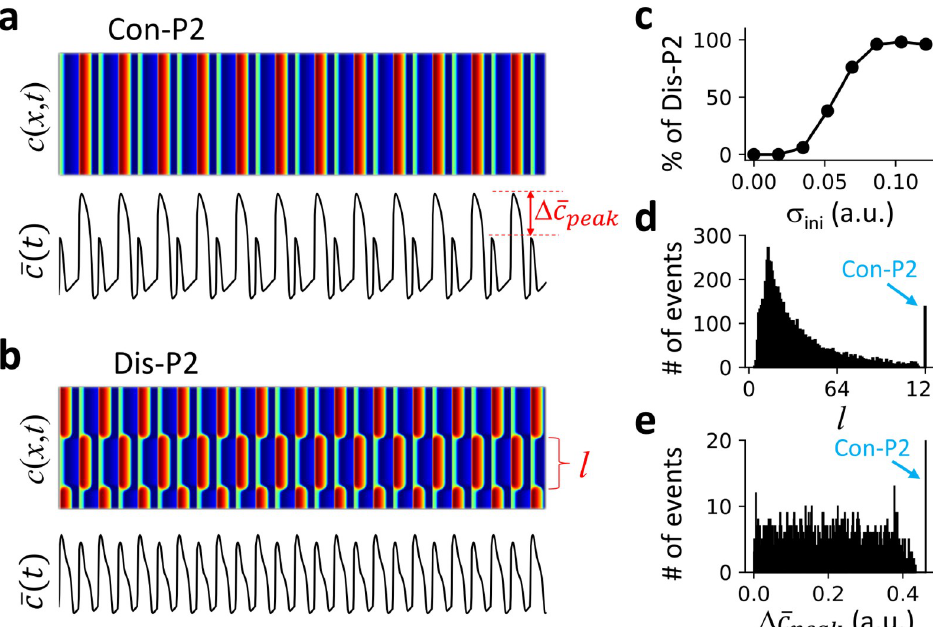
Fig 2. Excitation patterns and dynamics in a 1D array of coupled FHN units without DGF. The pacing period T = 45 and system size L = 128. a . An example of Con-P2 patterns and the corresponding global signal � c ð t Þ . b . An example of Dis-P2 patterns with a different initial condition from panel a, and the corresponding � c ð t Þ . c . Percentage of Dis-P2 patterns versus the standard deviation ( σ ini of the random initial conditions. s trials for each σ value in the plot. d . Histogram of domain size l (segment between two neighboring nodes, as ini indicated in panel b) from 2000 trials of random initial conditions with δ = 0.15. For each trial, 2000 beats were applied for the system to reach a steady state. The domain size was measured using the last two beats. e . Histogram of global P2 amplitude D � c , (difference between the peak values of two consecutive beats, as indicated in panel a) for the peak simulations in d. D � c was measured using the last two peak